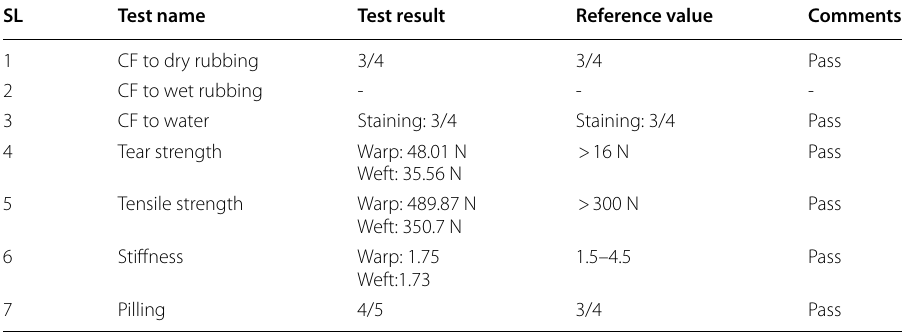
Table 3 Comparison of test results with the reference value of commercial denim trousers (Minimum Quality Requirement QA 6.0,